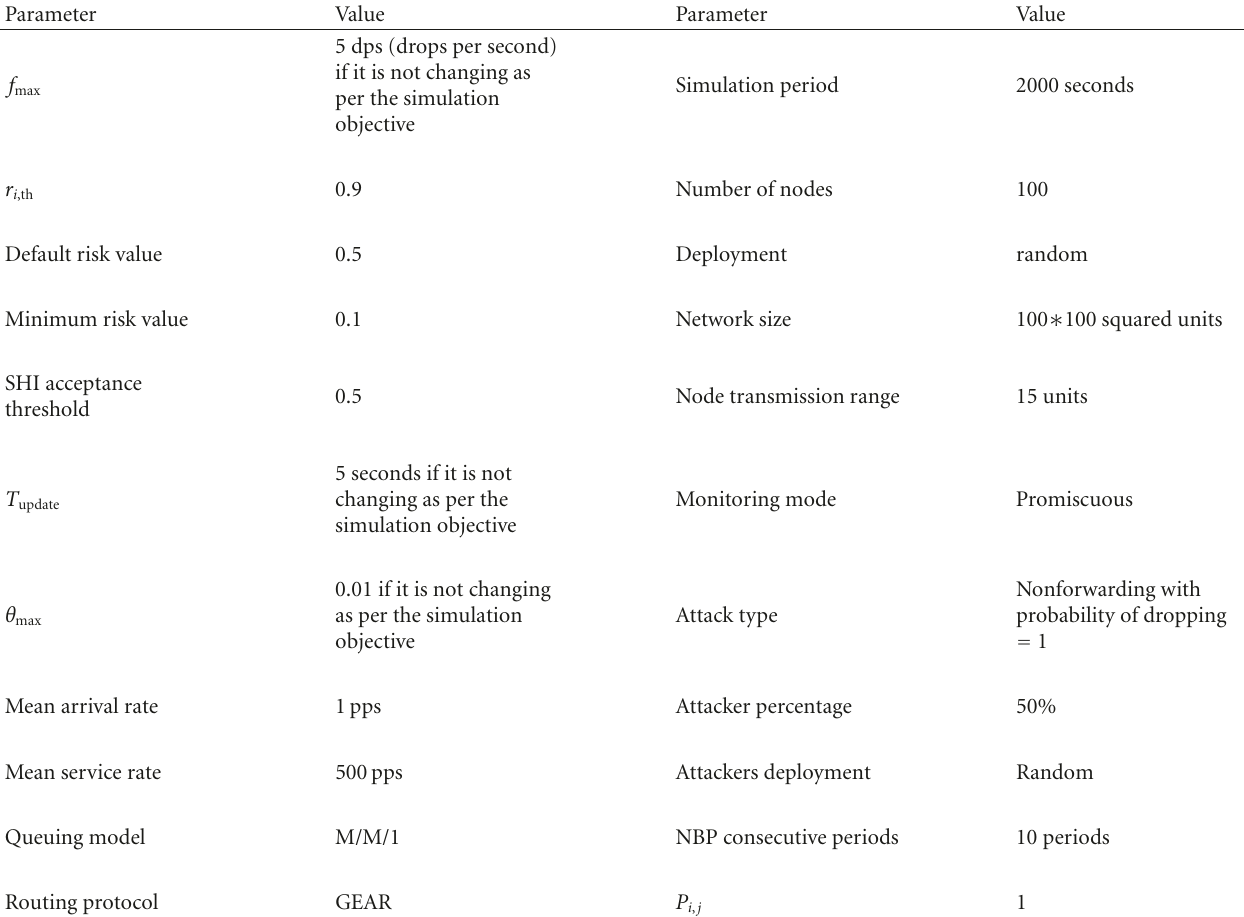
Table 1: Simulation parameters for CRATER